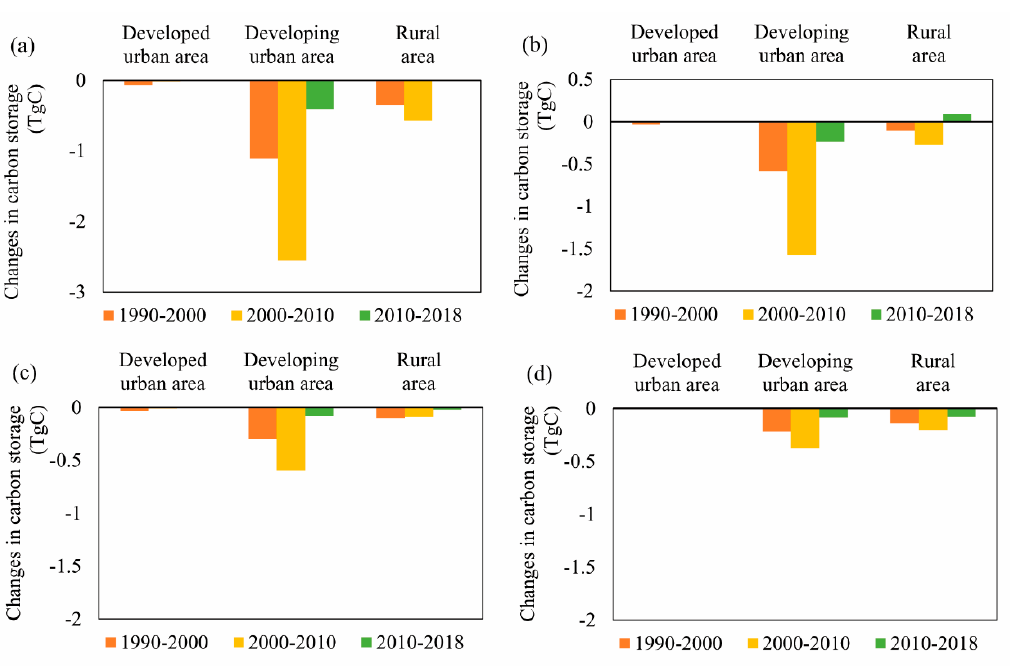
Table 8. The effects of the conversion of the main land-use types on carbon storage during 1990–2000. Land Use Type